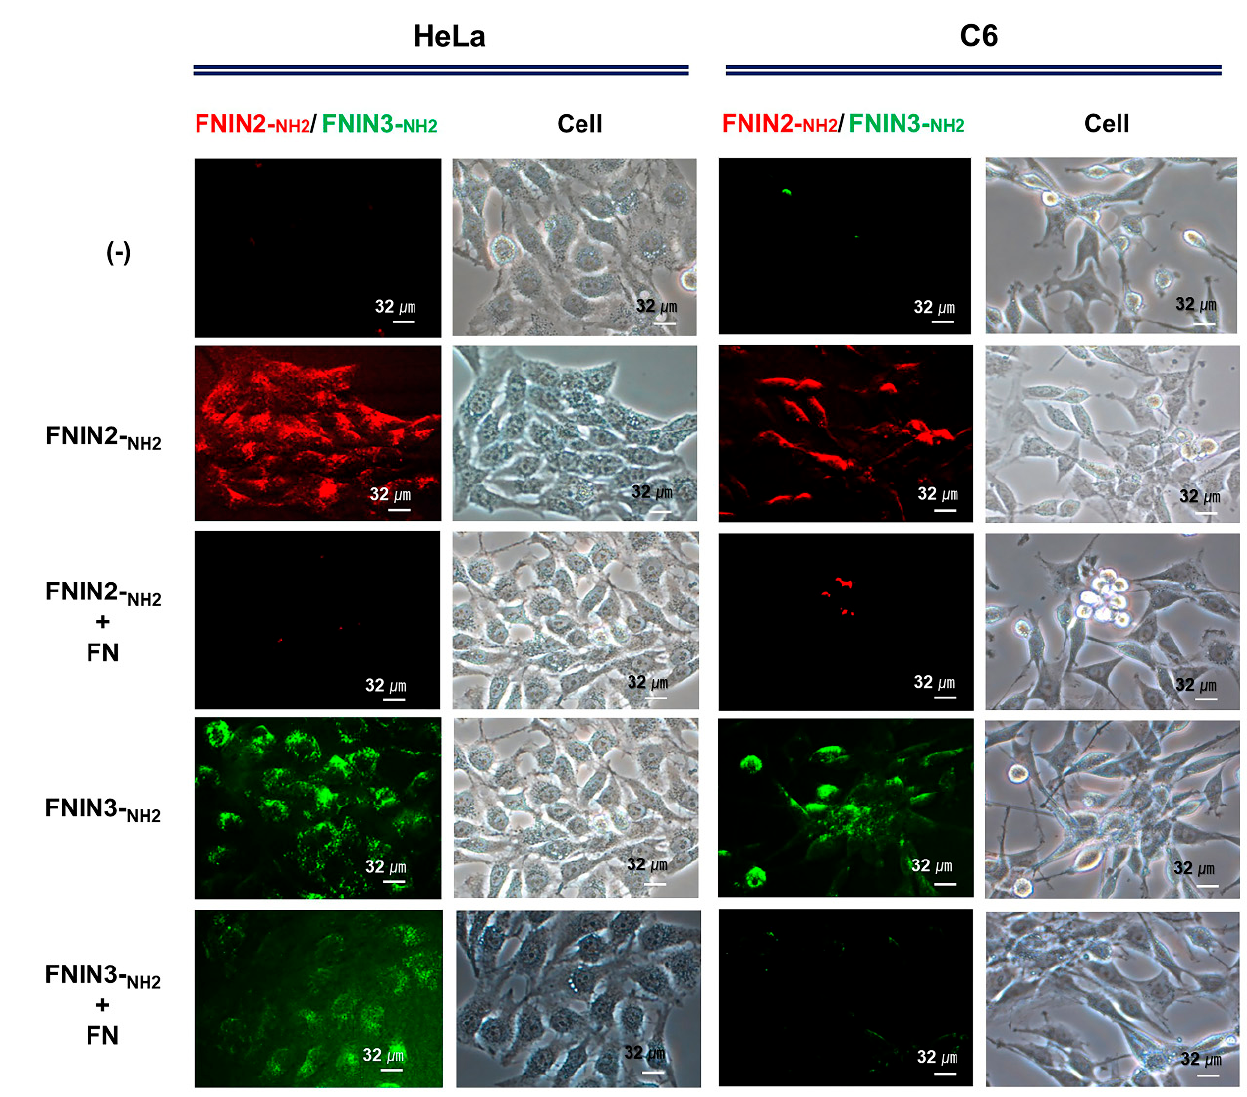
Figure 3. Detection of FNIN2- NH2 and FNIN3- NH2 with FN protein in HeLa and C6 cells. Rhodamine-labeled FNIN2- NH2 or FITC-labeled FNIN3- NH2 with FN protein was incubated in cultured media for 30 min, washed with PBS and observed under a fluorescence microscope.